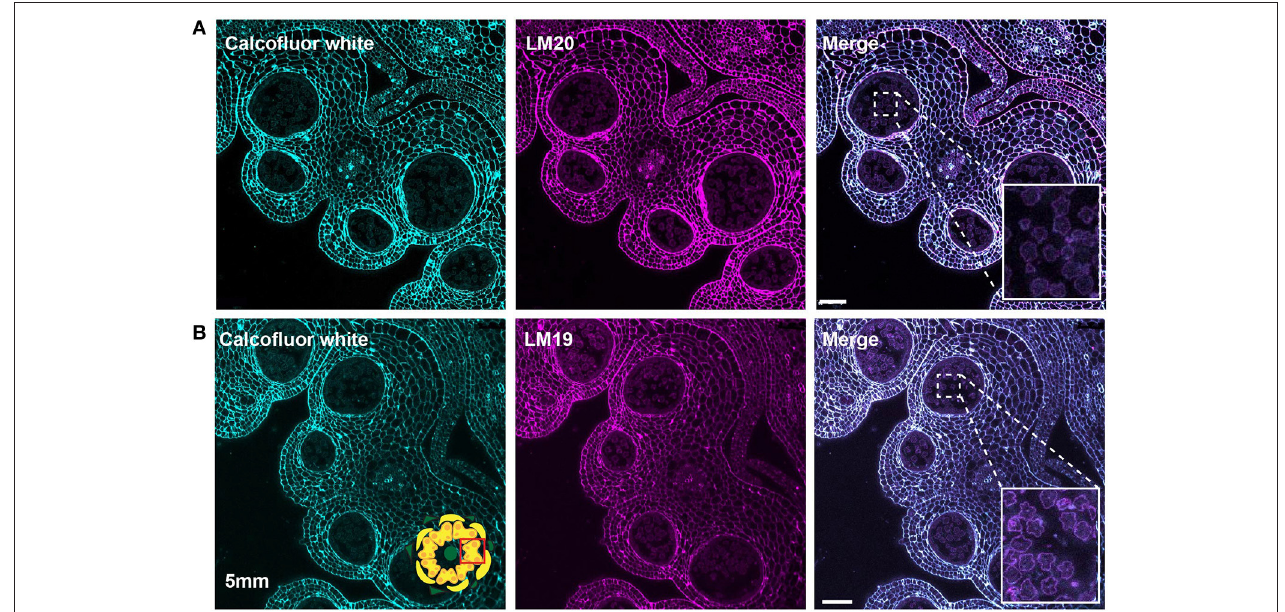
FIGURE 7 | LM20 and LM19 immunostaining of the 5-mm bud anthers. Fluorescent micrographs of anther cross sections (500nm) in LR white, of the 5-mm bud anther, stained with Calcofluor white and FITC conjugated secondary for LM20 or LM19. Calcofluor white staining (Cyan) (left). Aniline blue staining (magenta) (center). Merged staining (right). (A) LM20 staining of the 5-mm anther. The right panel inset, showing zoomed-in view of the microspore wall with the merged staining. (B) LM19 staining of the 5-mm anther. The right panel inset, showing zoomed-in view of the microspore with the merged staining. Scale bars 50 µ